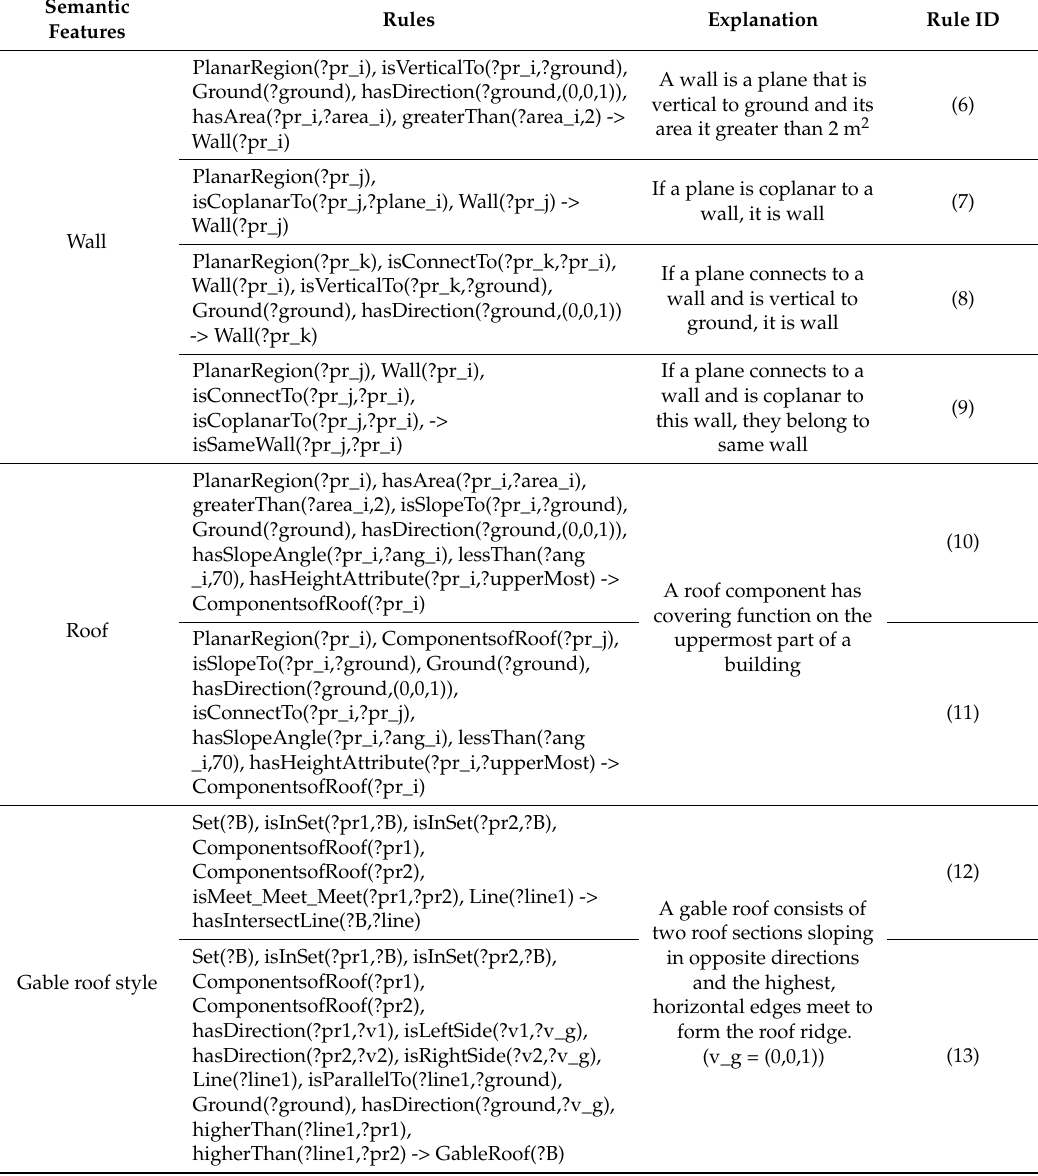
Table 4. Rules for the recognition of semantic features of